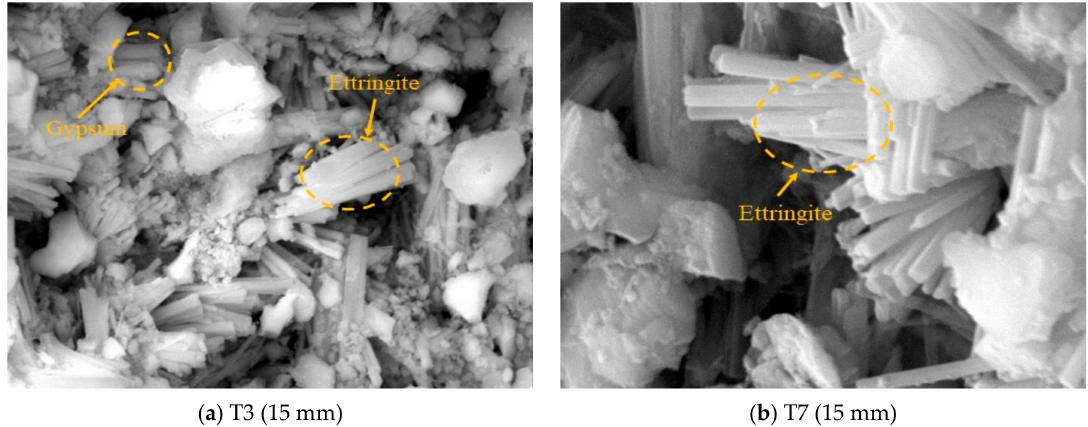
Figure 11. The microstructures of the specimens after sulfate dry–wet cycles for 210 days. ( a ) T3; ( b ) T7.